Question: What does this figure show? Answer in one sentence.
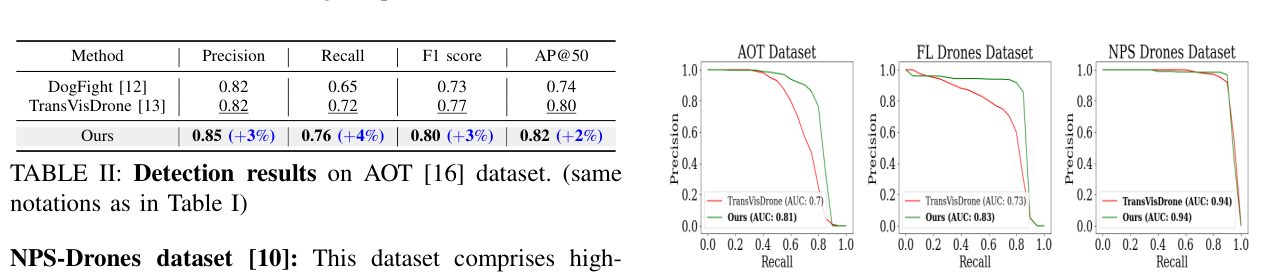
Answer: Comparison of Precision vs Recall curves between TransVisDrone [13] and Our method.